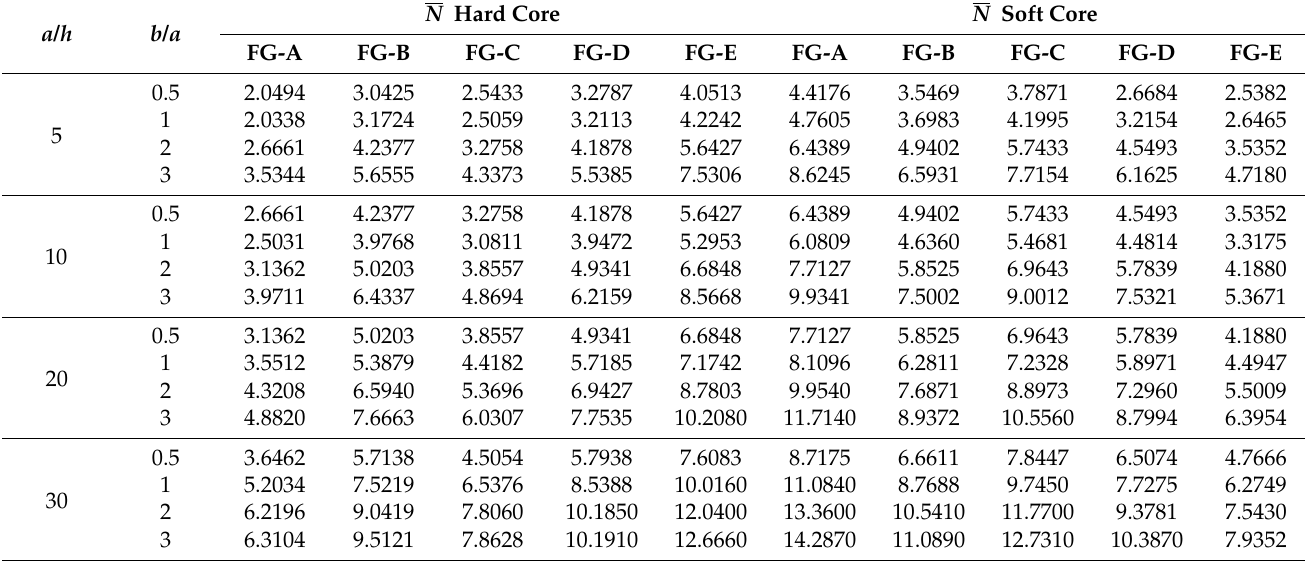
Table 5. Dimensionless critical buckling load N of FG shells versus the aspect and the thickness ratios (cid:0)